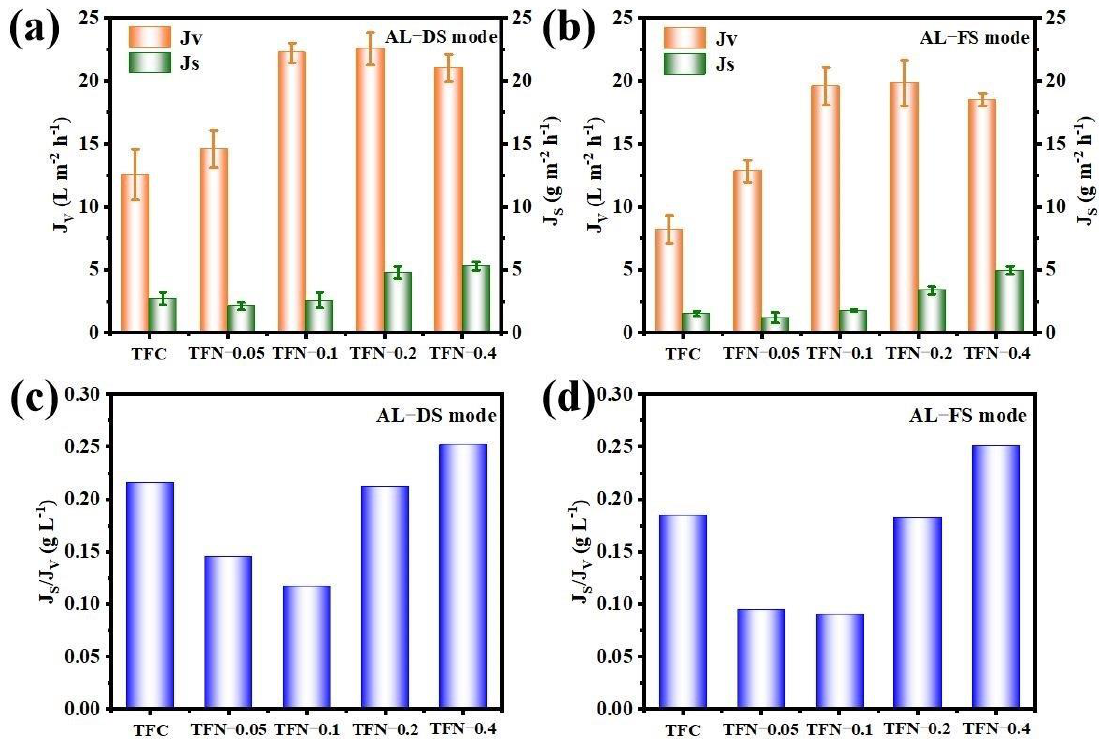
Figure 8. J V , J S and J S /J V of TFC and TFN membranes in FO applications under both AL-DS ( a , c ) and AL-FS ( b , d ) modes.